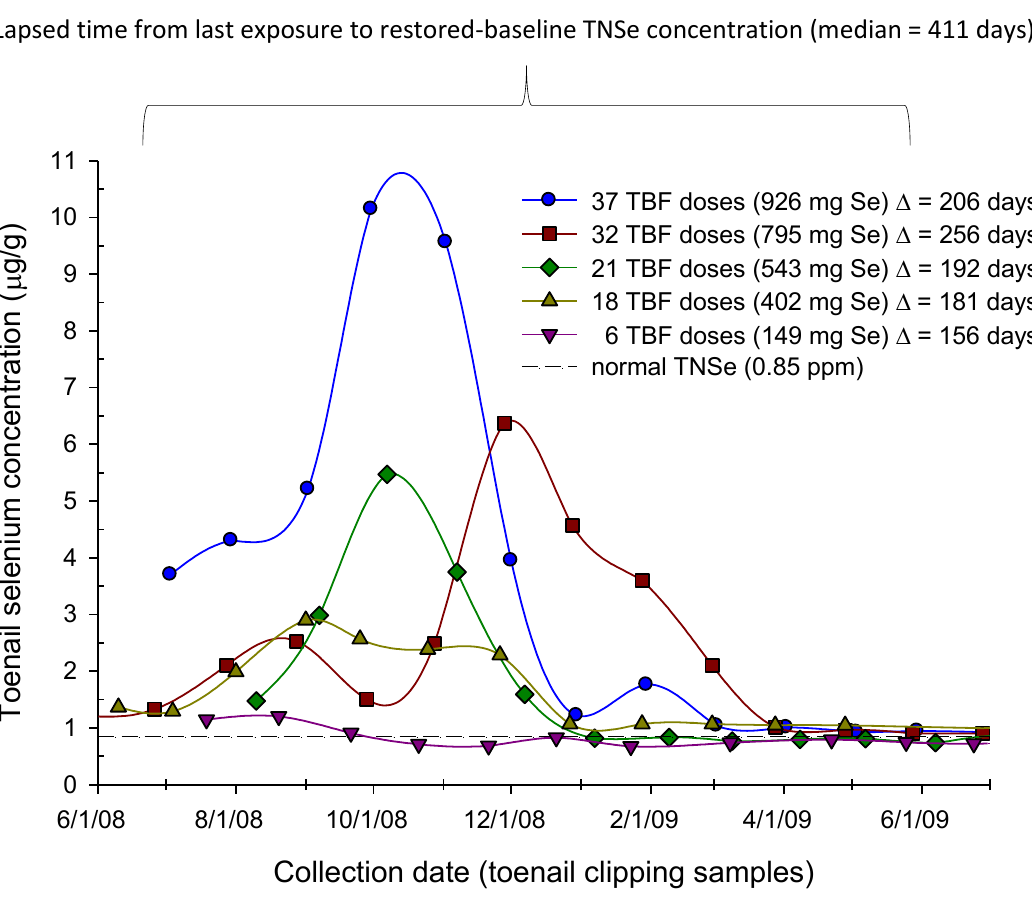
Figure 3. Temporal response in toenail Se concentration (μg/g) from monthly toenail clipping samples relative to Se exposure (6 to 37 doses; 149 to 926 mg Se) from misformulated TBF supplement products. The temporal response in toenail Se (TNSe) concentration for 5 representative subjects ranging in Se exposure from 6 to 37 doses (149 to 926 mg Se) who were able to submit monthly samples is somewhat variable in the breadth of the elimination period, the number of peaks, and the lapsed time from last use of the misformulated product to the peak TNSe concentration (Δ days). The peak TNSe concentration is highly correlated with total Se intake from the TBF products ( r = 0.96, p = 0.01) in these 5 subjects. The median lapsed times spanning the last exposure to the TNSe peak concentration and the restored-baseline concentration, were 237 and 411 days,